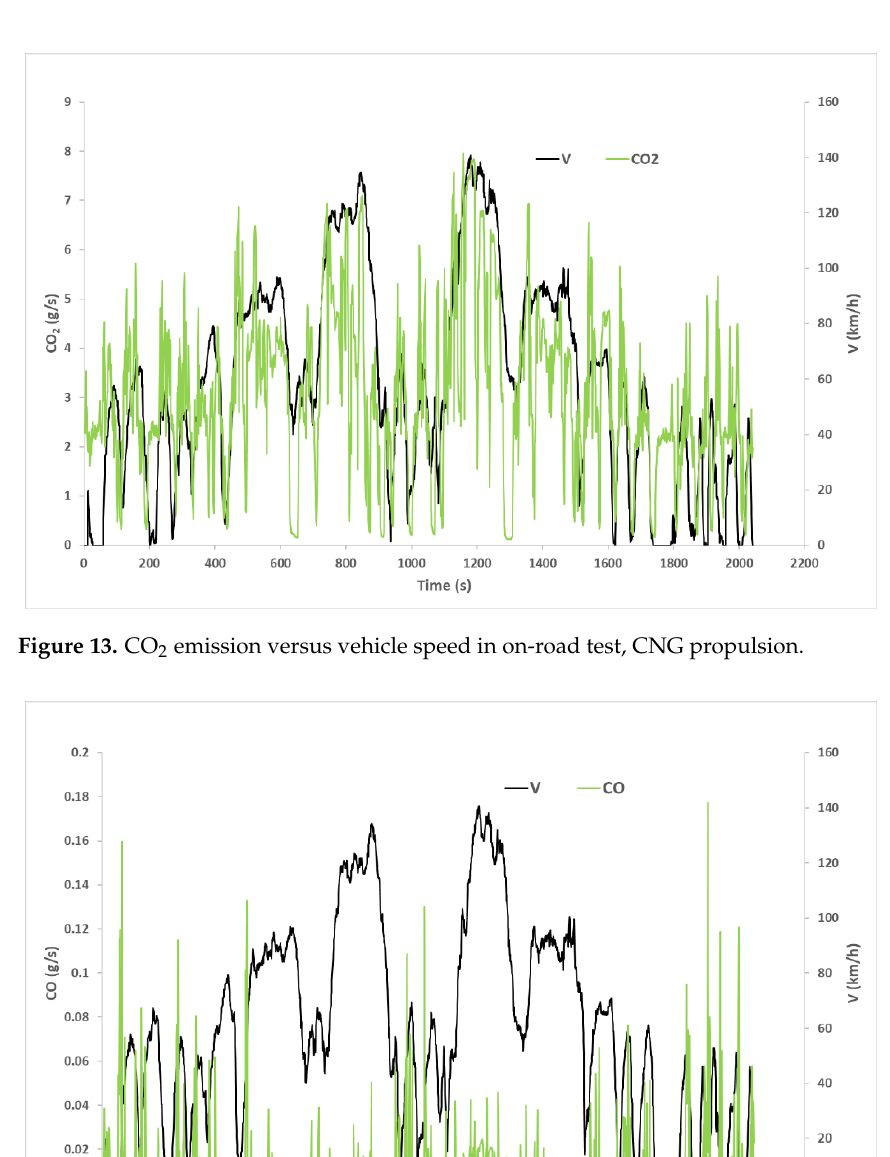
Figure 12. CO emission versus vehicle speed in on-road test, petrol propulsion.